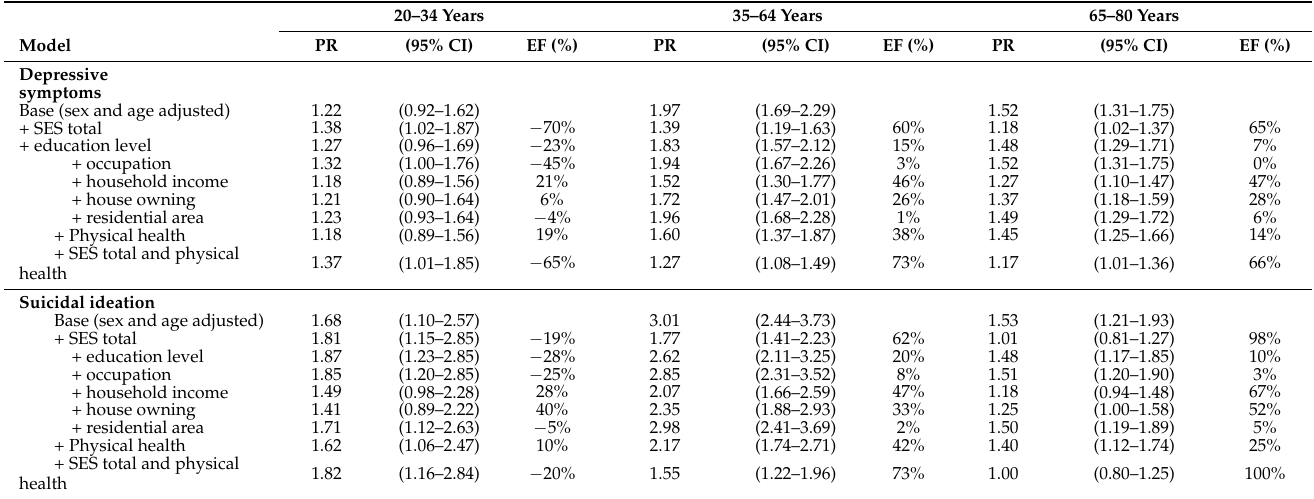
Table 5. Explained proportion of the socioeconomic factors and physical health in the excess preva- lence of depressive symptoms or suicidal ideation in those living